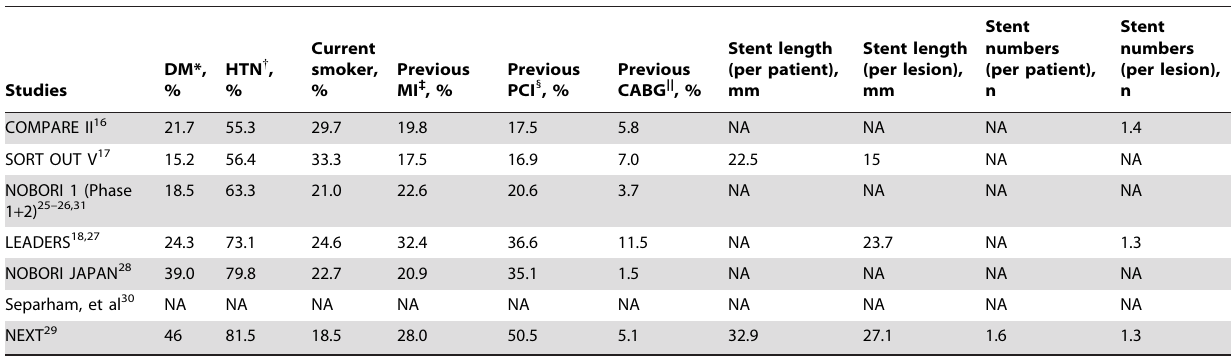
Table 2. Characteristics of included